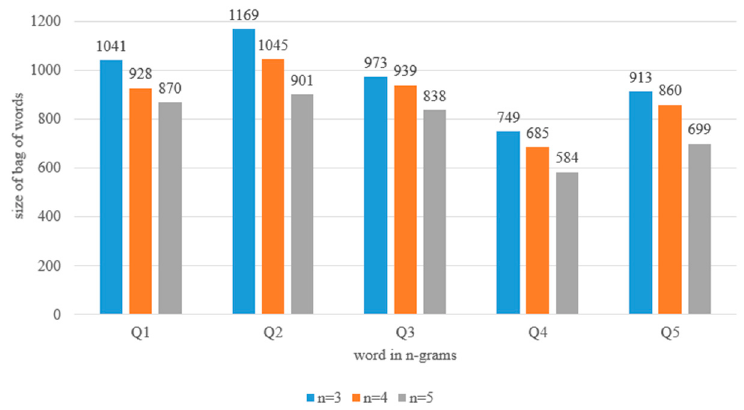
Figure 4. The size of the obtained bag of words.